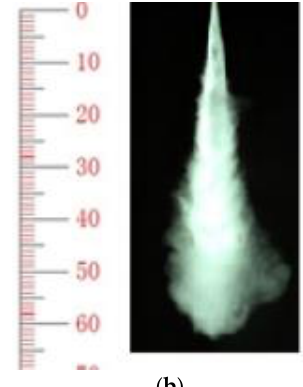
results for Case 2.